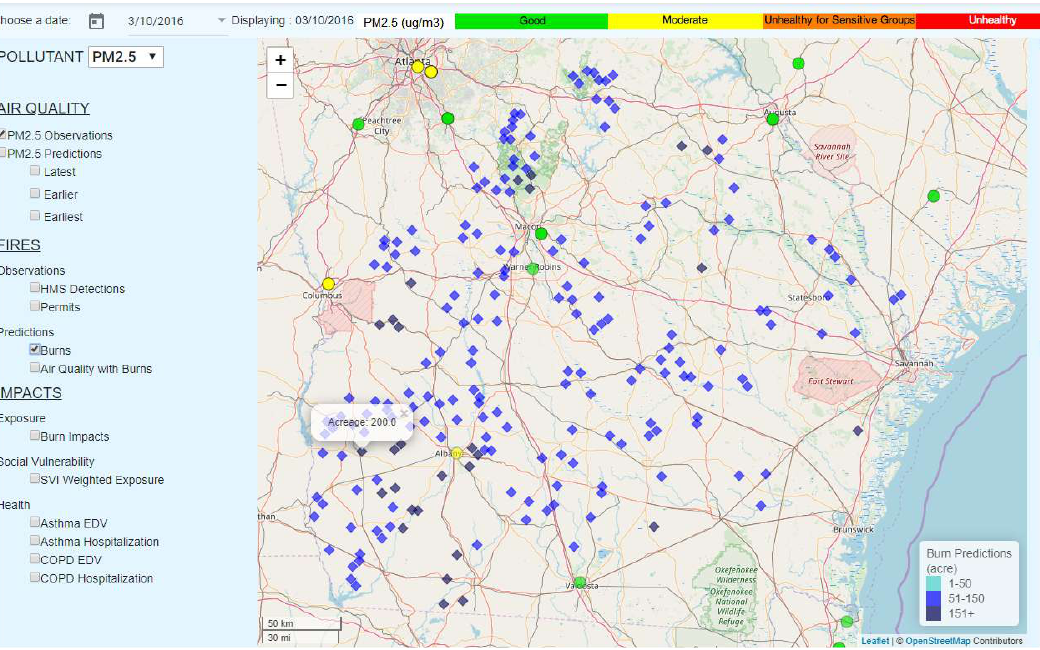
Figure A2. The SIPFIS webpage displays Forecast Burns as blue diamonds (in three different shades).